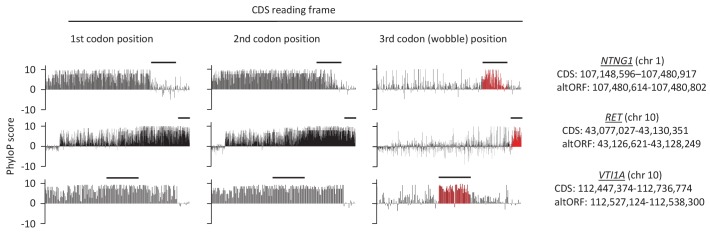
First, second, and third codon nucleotide PhyloP scores for 100 vertebrate species for the CDSs of the NTNG1, RET and VTI1A genes.Chromosomal coordinates for the different CDSs and altORFs are indicated on the right. The regions highlighted in red indicate the presence of an altORF characterized by a region with elevated PhyloP scores for wobble nucleotides. The region of the altORF is indicated by a black bar above each graph.10.7554/eLife.27860.015Figure 4—source data 1.AltORFs completely nested within CDSs show more extreme PhyloP values (more conserved or faster evolving) than their CDSs.